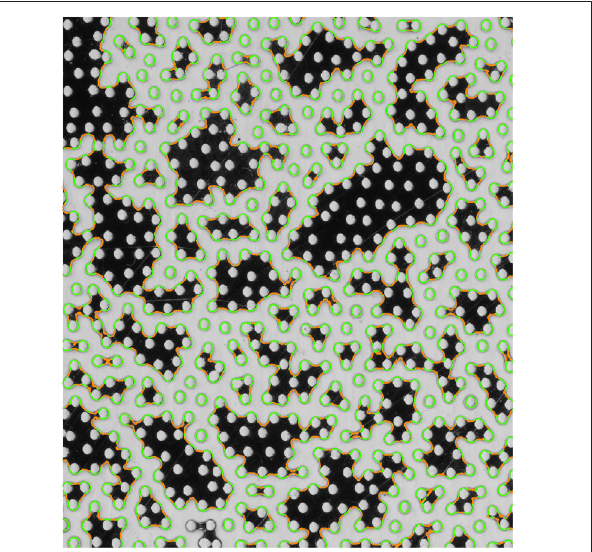
FIGURE 5 | Tracking of the internal interfacial contours between the nonwettingand wettingphases (orange)and thenonwettingandsolidphases